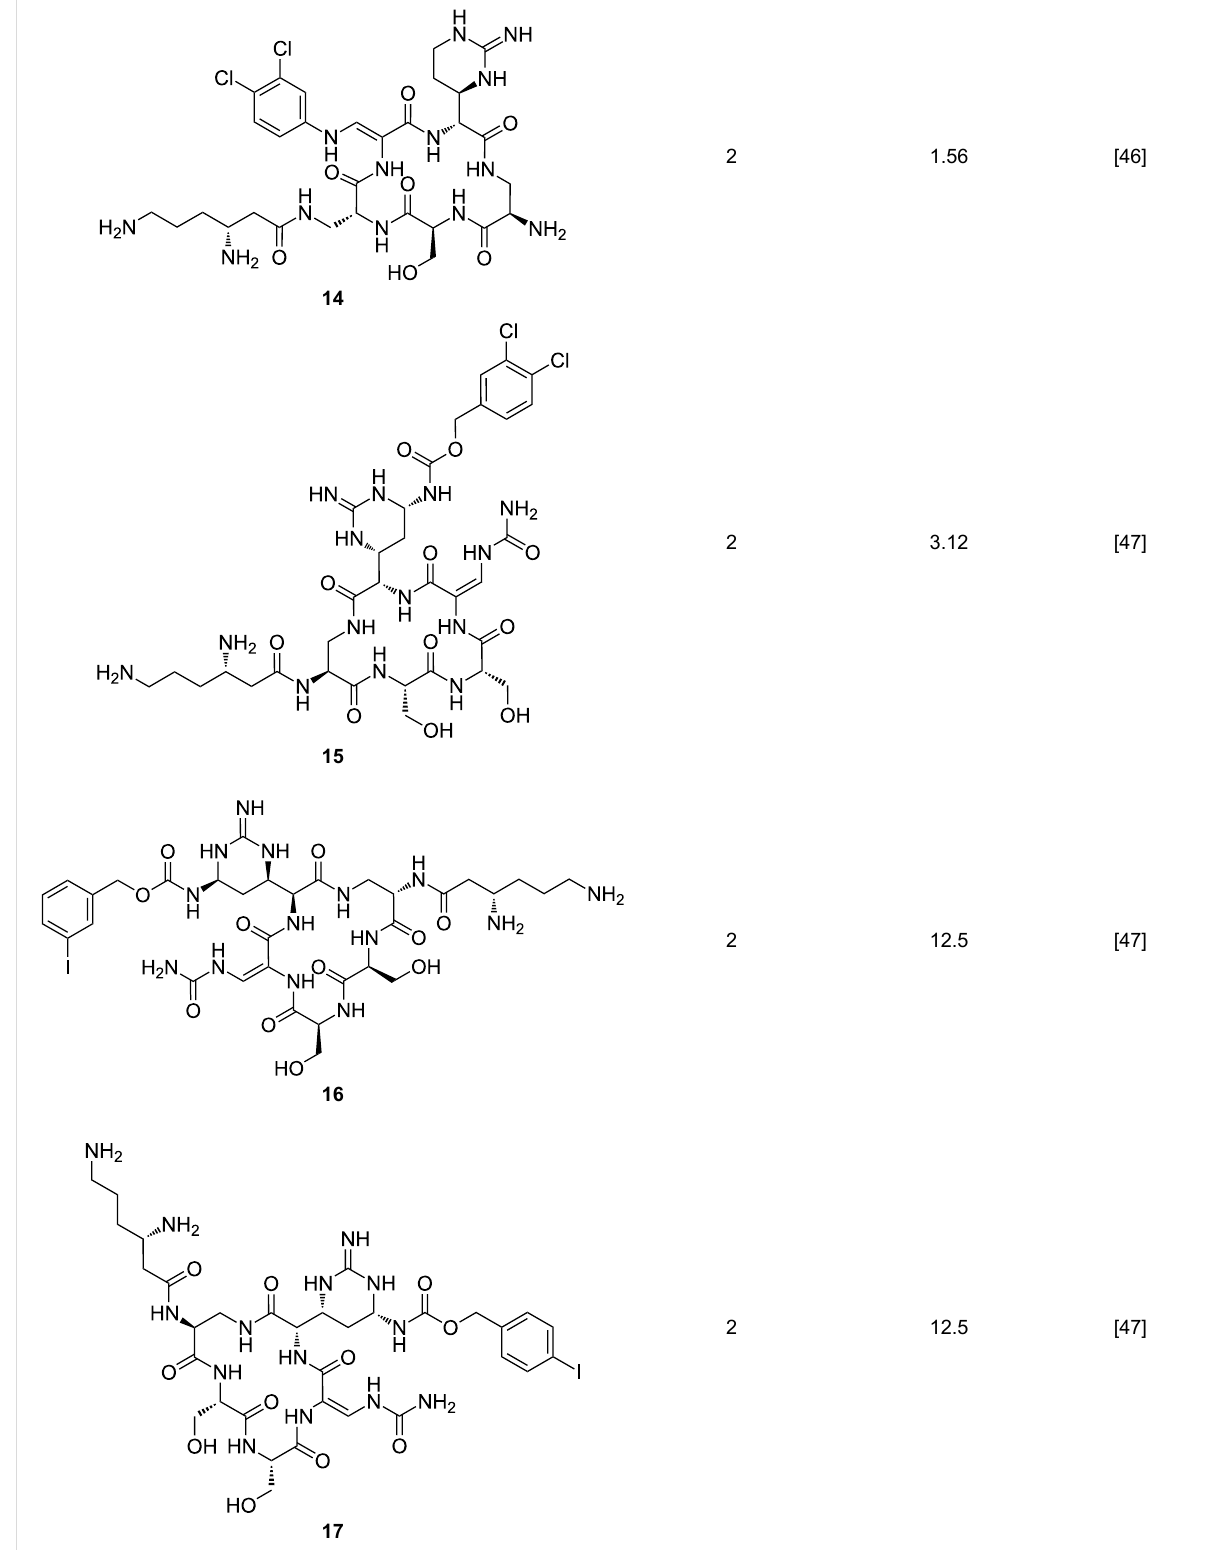
Table 1: Structures of cyclic peptides with their MIC values.